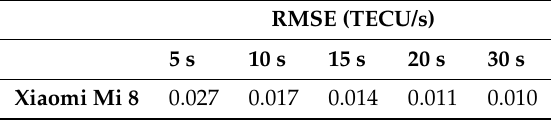
Figure 11. The trend of ∆ sTEC / ∆ t with respect to GPS satellite G24 for M0SE and for Xiaomi Mi8 are respectively depicted in blue and red. Table 4. RMSEs of Xiaomi Mi8 moving median series for satellite G24 for different time